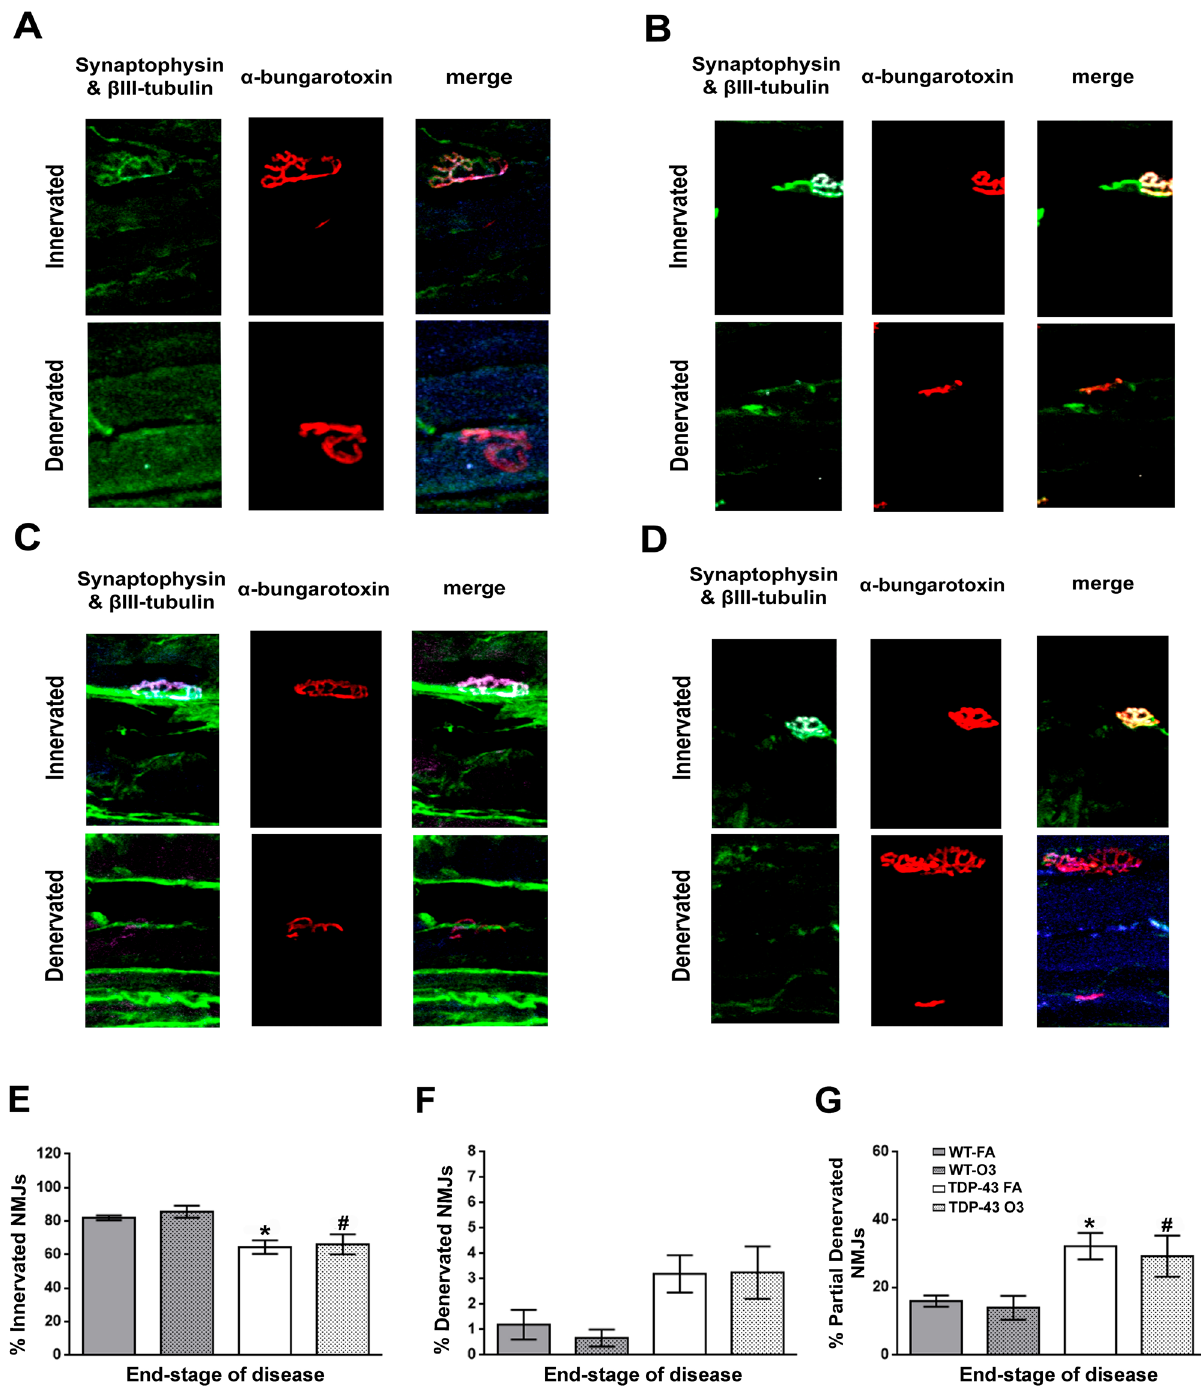
Figure 7. O 3 exposure did not alter the NMJs denervation state in the TA muscle in TDP-43 A315T mice at the end-stage of the disease. Representative examples of NMJ immunostaining in TA muscle of WT mice exposed to FA (n = 6 mice) ( A ) or O 3 (n = 8 mice) ( B ), and TDP-43 A315T mice exposed to FA (n = 5 mice) ( C ) or O 3 (n = 7 mice) ( D ). Quantification of innervation ( E ), denervation ( F ) and partial denervation ( G ) at the end- stage of disease. Values are expressed as the mean ± SEM for the different groups. Comparison between groups was performed by two-way ANOVA followed by Dunnett’s post hoc test to compare all groups with WT-FA, while Tukey’s post hoc test was used for multiple comparisons between all groups, where * p < 0.05 vs. WT mice FA-exposed; # p < 0.05 vs. WT mice O 3 -exposed. Abbreviations: WT, Wild-type mic; TDP-43, TDP-43 A315T mice; FA, filtered air; O 3,